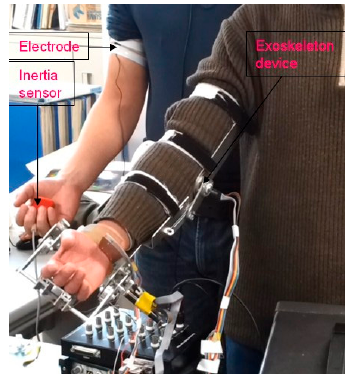
Figure 15. Two subjects performing elbow flexion and extension, where one subject attached one electrode to the surface of the bicep muscle, and the other subject wore an exoskeleton device.